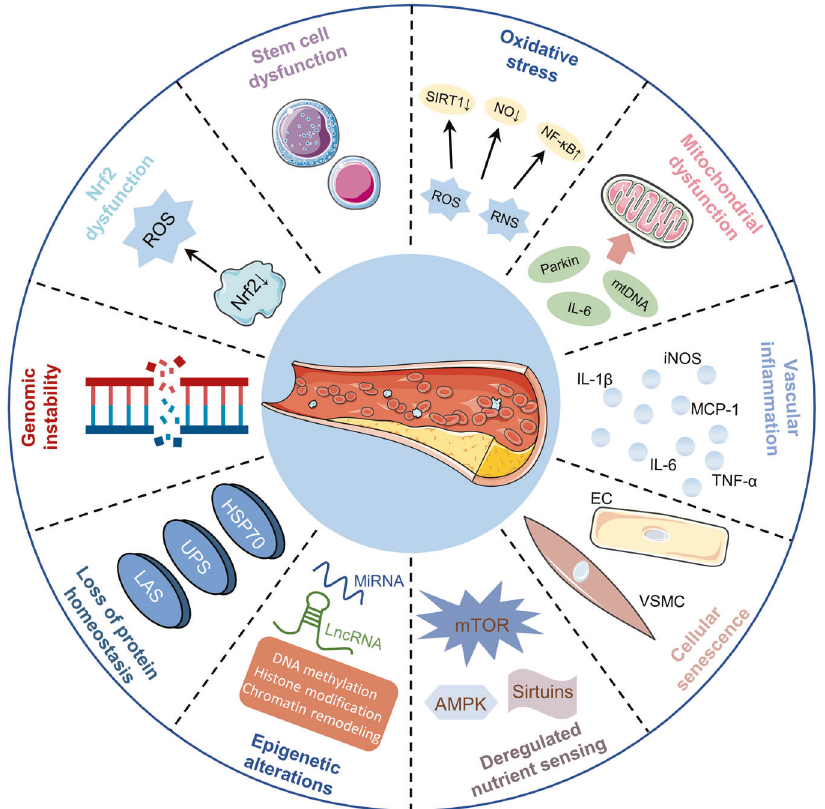
Fig. 4 Mechanisms of vascular aging. A broad range of molecular and cellular events, including oxidative stress, mitochondrial dysfunction, vascular in fl ammation, cellular senescence, epigenetic alterations, genomic instability, impaired resistance to molecular stressors, deregulated nutrient sensing, loss of protein homeostasis, and stem cell dysfunction are involved in the pathology of vascular aging. This fi gure was created with the aid of Servier Medical Art (https://smart.servier.com/). ROS reactive oxygen species, RNS reactive nitrogen species, SIRT1 sirtuin 1, NO nitric oxide, NF- κ B nuclear factor-kappaB, IL-6 interleukin-6, mtDNA mitochondrial DNA, iNOS inducible nitric oxide synthase, MCP-1 monocyte chemotactic protein-1, TNF- α tumor necrosis factor alpha, EC endothelial cell, VSMC vascular smooth muscle cell, mTOR mechanistic/mammalian target of rapamycin, AMPK adenosine monophosphate protein kinase, miRNA microRNA, lncRNA long non- coding RNA, UPS ubiquitin-proteasome system, LAS lysosome-autophagy system, Nrf2 nuclear factor erythroid 2-related factor